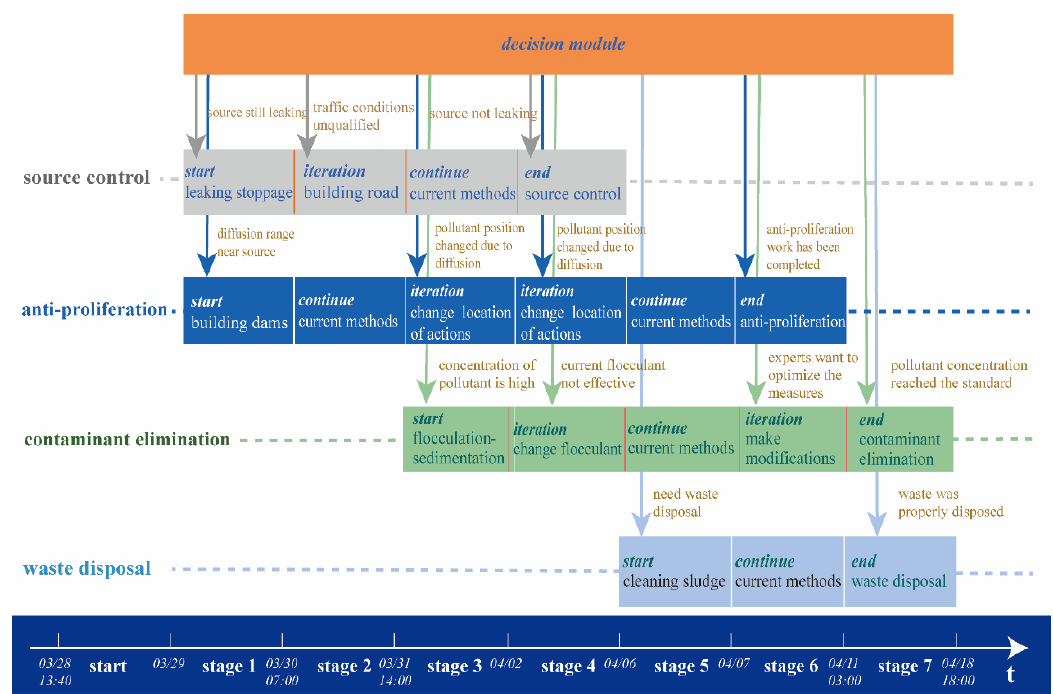
Figure 5. Time process of the event and the actions.